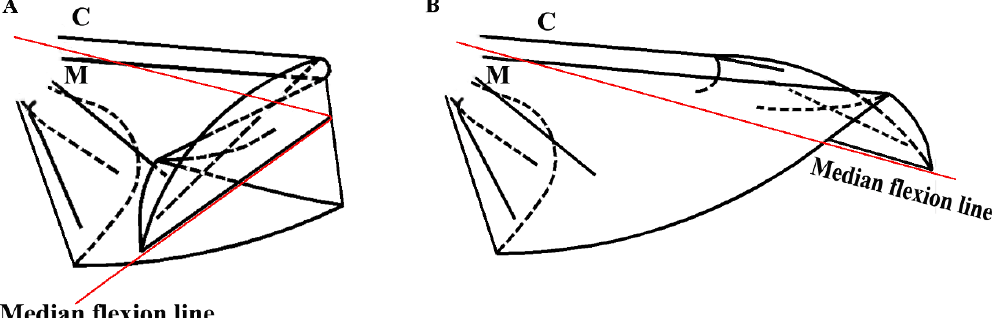
Figure 5. Schematic representation of the unfolding mechanism of the hind wings of Dorcus titanus platymelus . ( A ) Fully opened wing; and ( B ) Folded wing. C, costa; M, media